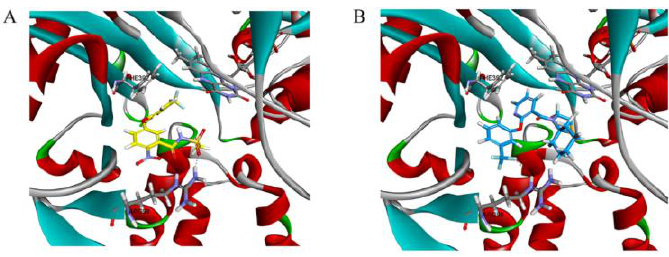
Figure 6. Zoomed-in view of the docking modeling of fomesafen ( A ) and 4i ( B ) with PPO at active site. The carbon atoms are shown in yellow ( A ) and indigo ( B ); the sulfur atoms are shown in brown ( A , B ); the oxygen atoms are shown in red ( A , B ); the nitrogen atoms are shown in blue ( A , B ).